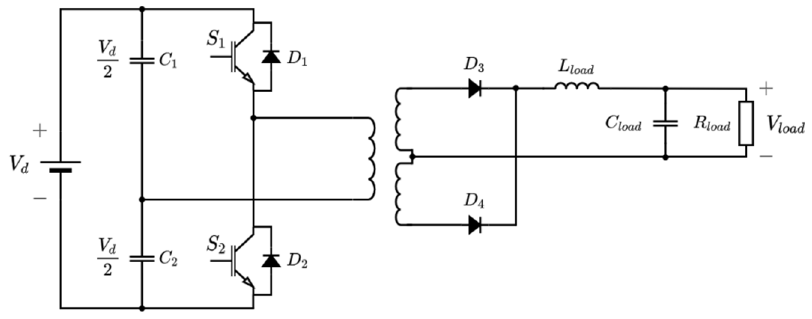
Figure 17. Isolated half-bridge DC/DC converter.